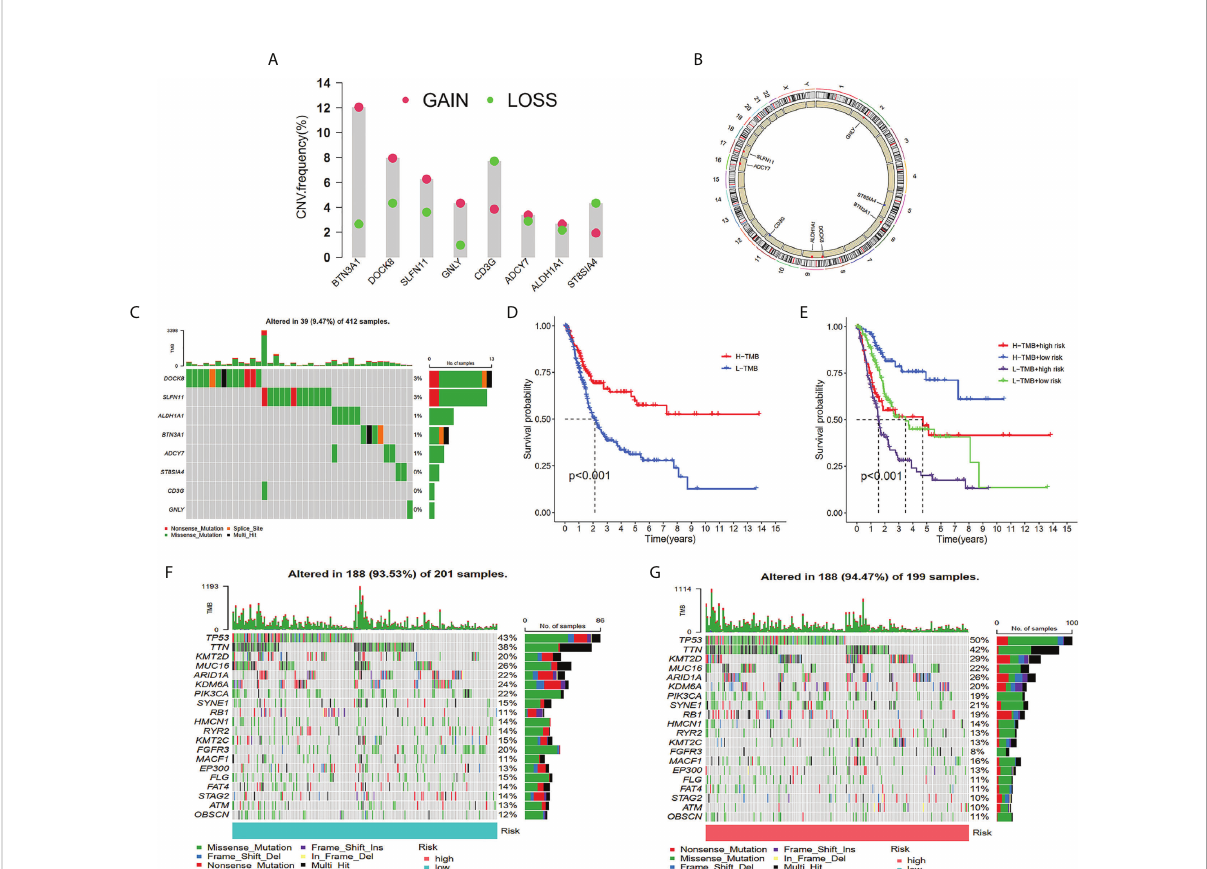
FIGURE 6 Tumor mutation analysis between different TILS groups. Frequencies of gain and loss for selected genes from the TILS (A) . Circus plots of chromosome distributions of selected genes from the TILS (B) . Gene network of TILS (C) . Mutation frequency of the TILS of BCa patients in the TCGA-BLCA cohort (D) . Kaplan-Meier curves showed that high tumor mutation burden (H-TMB) subgroup had better survival probability than Low-TMB (L-TMB) subgroup in the TCGA-BLCA (E) . The Kaplan-Meier curve survival analysis for BCa patients strati fi ed by both TMB groups and TILS (F) . Waterfall plot displaying gene mutations in the low- (G) and high-risk (H)